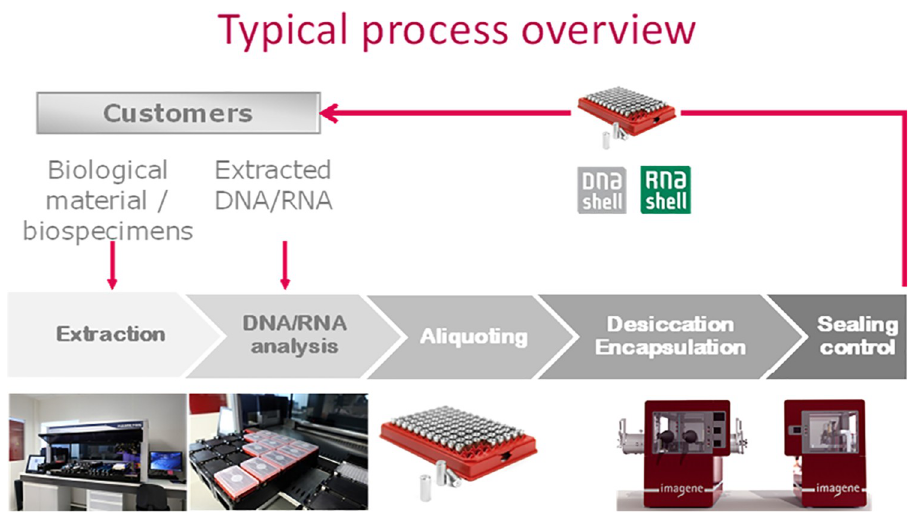
Fig 1. Workflow of Imagene